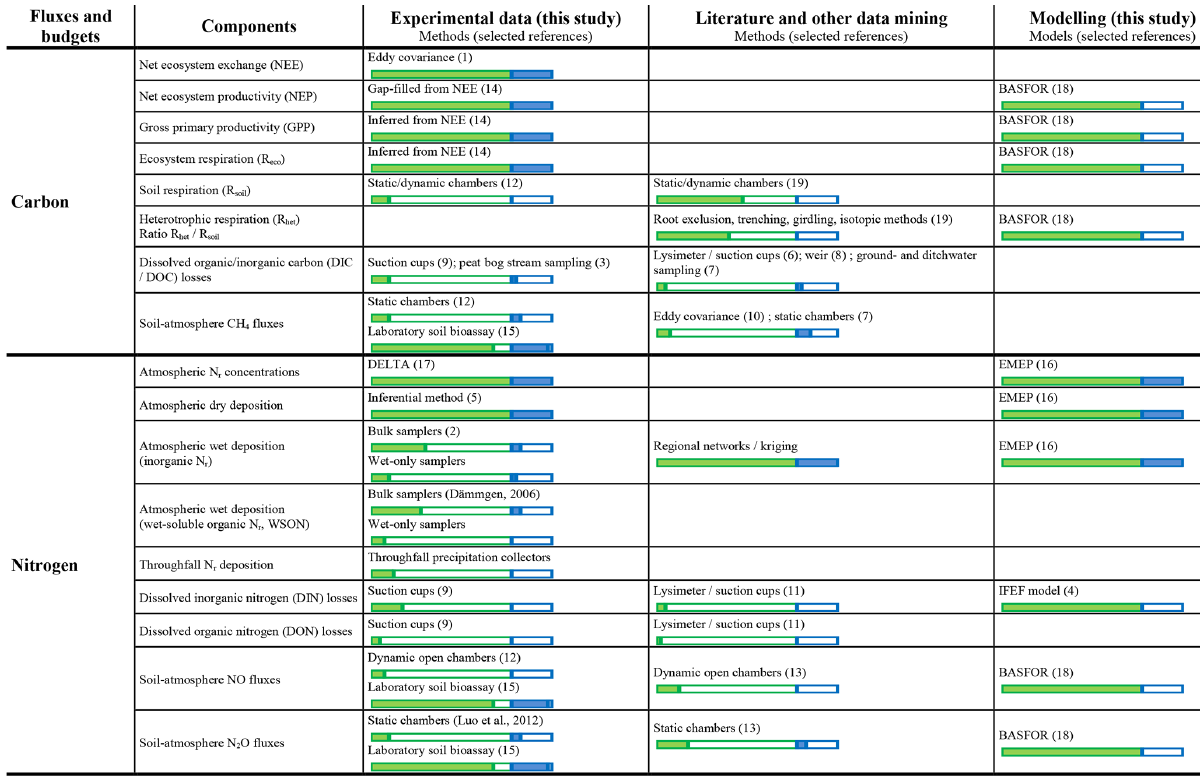
Table 3. Summary of the main methods used to quantify carbon, nitrogen, and greenhouse gas fluxes and budgets for the 31 forests and nine short semi-natural vegetation sites included in this study. Horizontal bars (green: forests; blue: short semi-natural vegetation) indicate the percentage of study sites with available data (filled bars) or without available data (open bars). See also Tables S6–S7 for details at individual